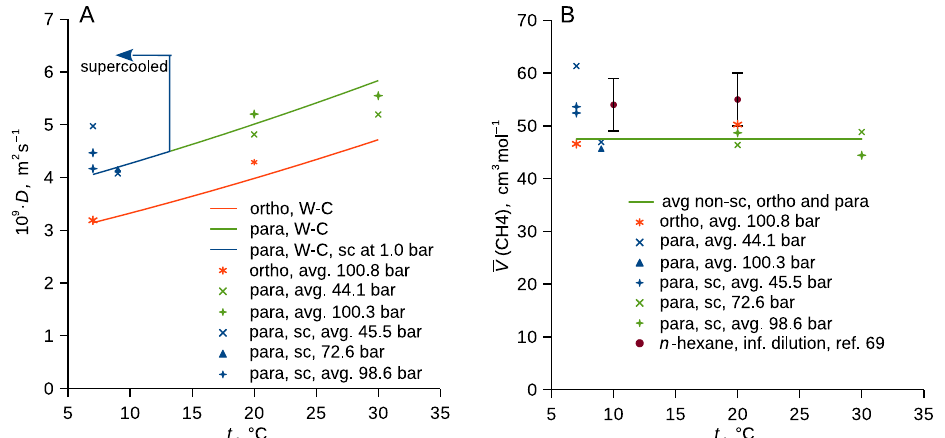
Figure 6. ( A ) Diffusivity and ( B ) partial molar volume of methane for its binary solutions with perdeuterated p -xylene ( p- C 8 D 10 ) and o -xylene ( o- C 8 D 10 ). Typical uncertainties of diffusivity and partial molar volume due to random error ( u r , cover factor 2) are 0.3·10 –9 m 2 s −1 and 7 cm 3 mol −1 , respectively. Curves in ( A ) represent the